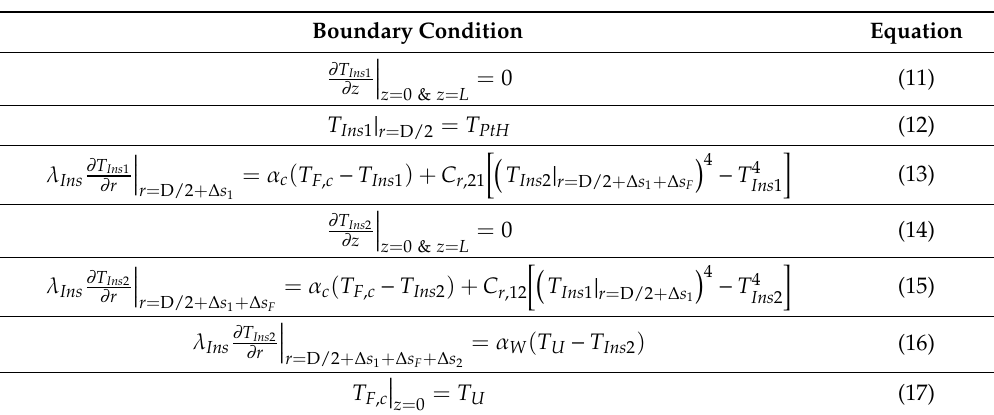
Table 2. Boundary conditions for the alternative